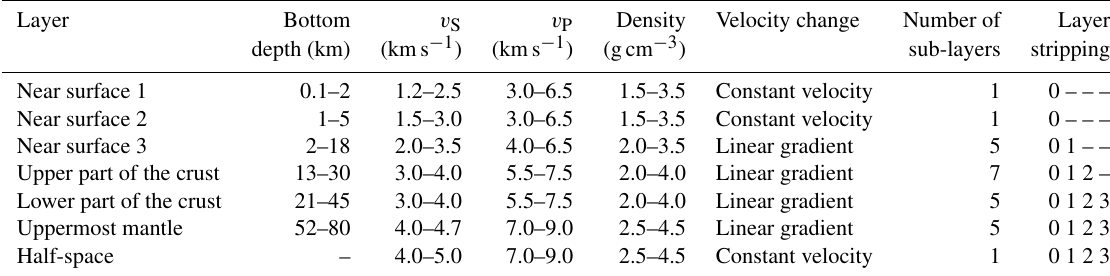
Table 1. Range of parameters for the neighbourhood algorithm (NA) stochastic inversion. Layer Bottom v S v P Density Velocity change Number of Layer depth (km) (kms − 1 ) (kms − 1 ) (gcm − 3 ) sub-layers stripping Near surface 1